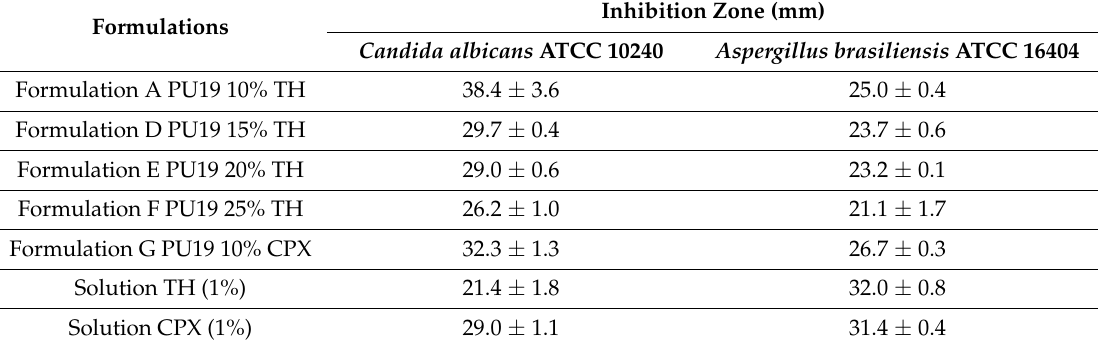
Table 5. Inhibition zone (mm) of all formulations in plate dish for Candida albicans , and Aspergillus brasiliensis (mean ± SD, n = 2).